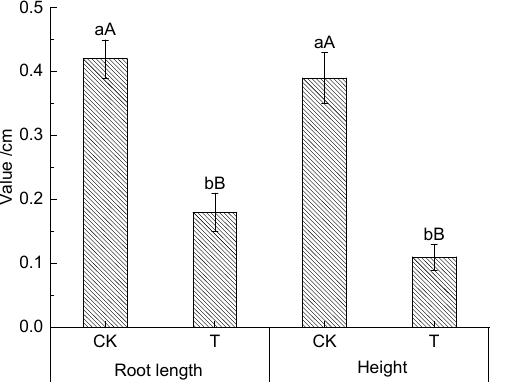
Figure 2. The effects of PBAT-BMF extract on root length and height of tobacco seedlings (A and B were p < 0.01 statistical significance, a and b were p < 0.05 statistical significance).